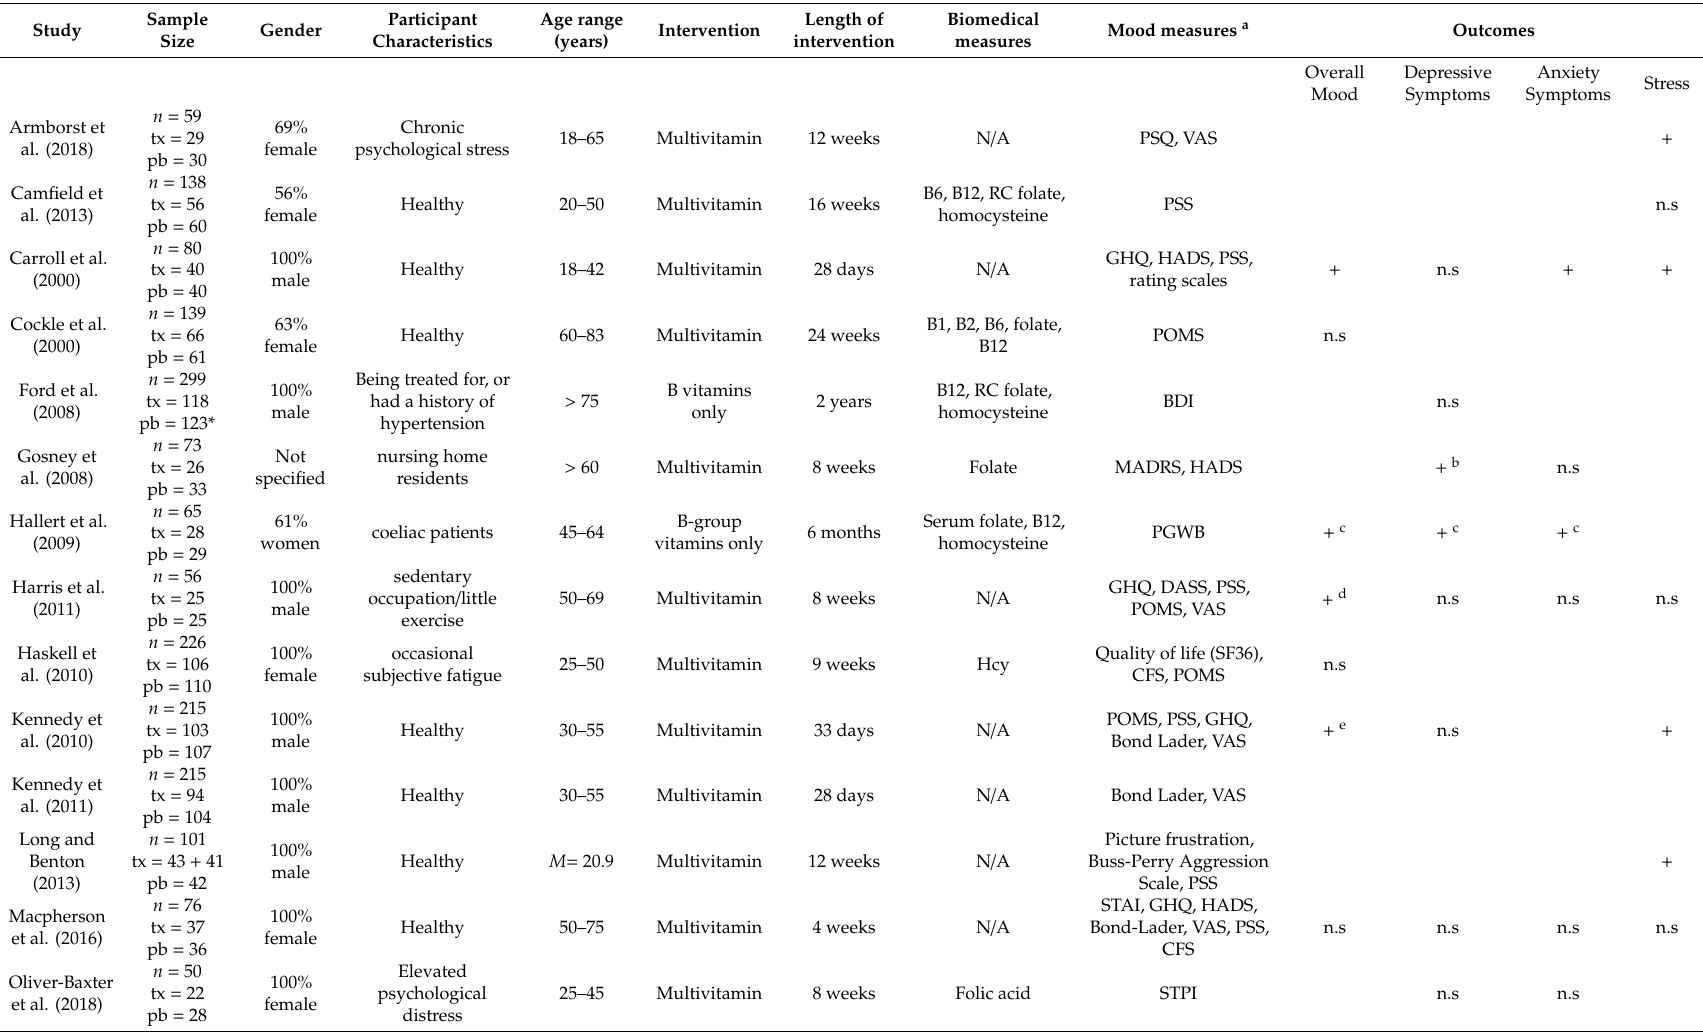
Table 1. Randomized, Double-Blind, Placebo-Controlled Trials investigating the e ff ects of B vitamins on